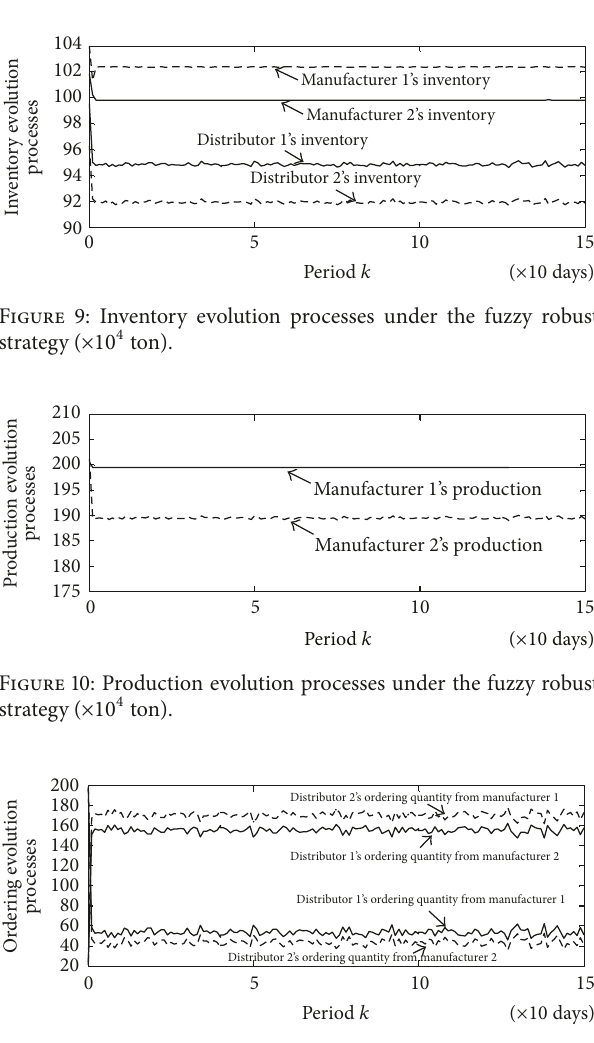
Figure 8: Total cost evolution process under the common robust strategy ( ×10 8 RMB).